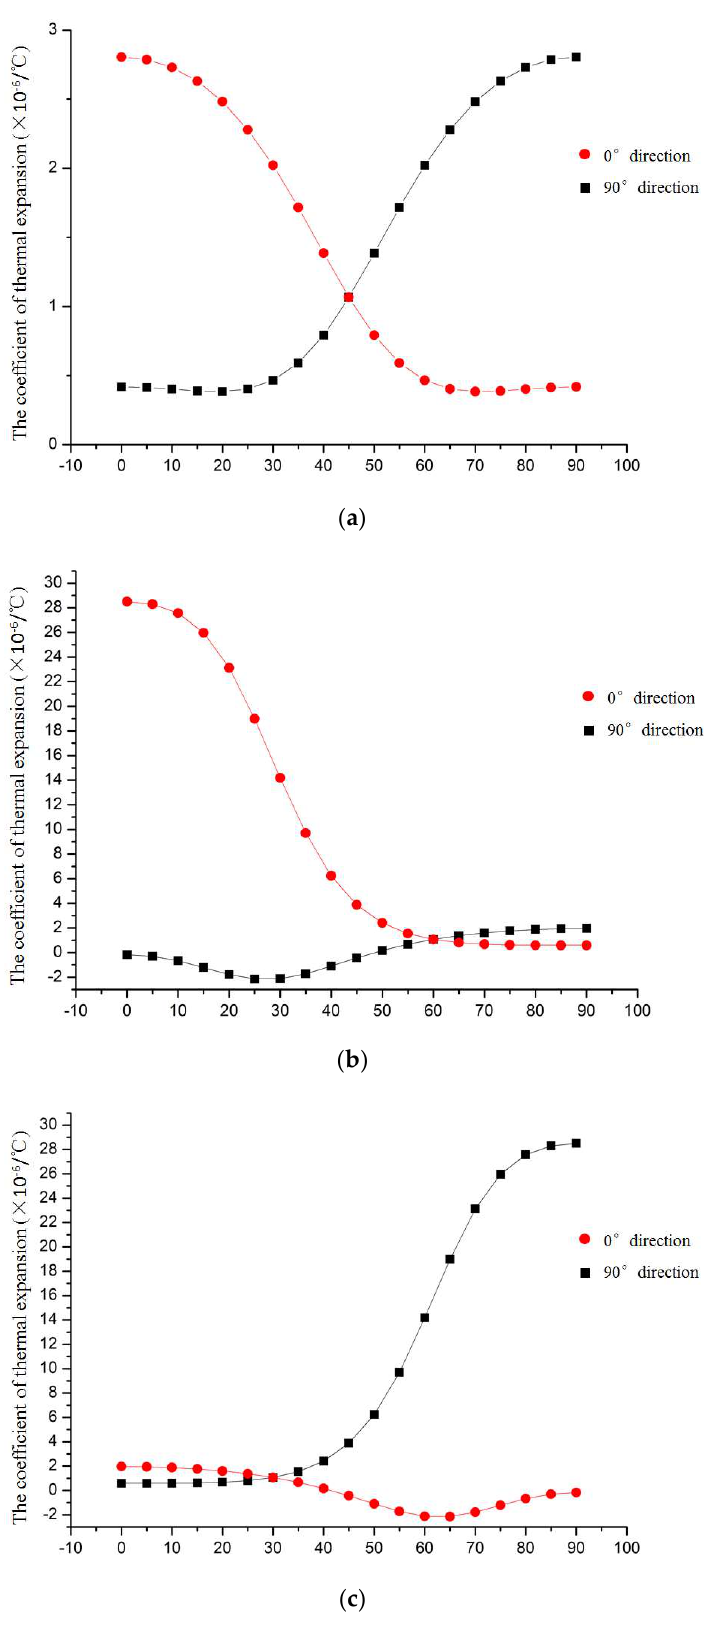
Figure 4. The relationship between the CTE and ply angel of M40 composite material with respect to the plying style: ( a ) ±θ/0°/90°, ( b ) ±θ/0°/ ∓ θ, ( c ) ±θ/90°/ ∓ θ.